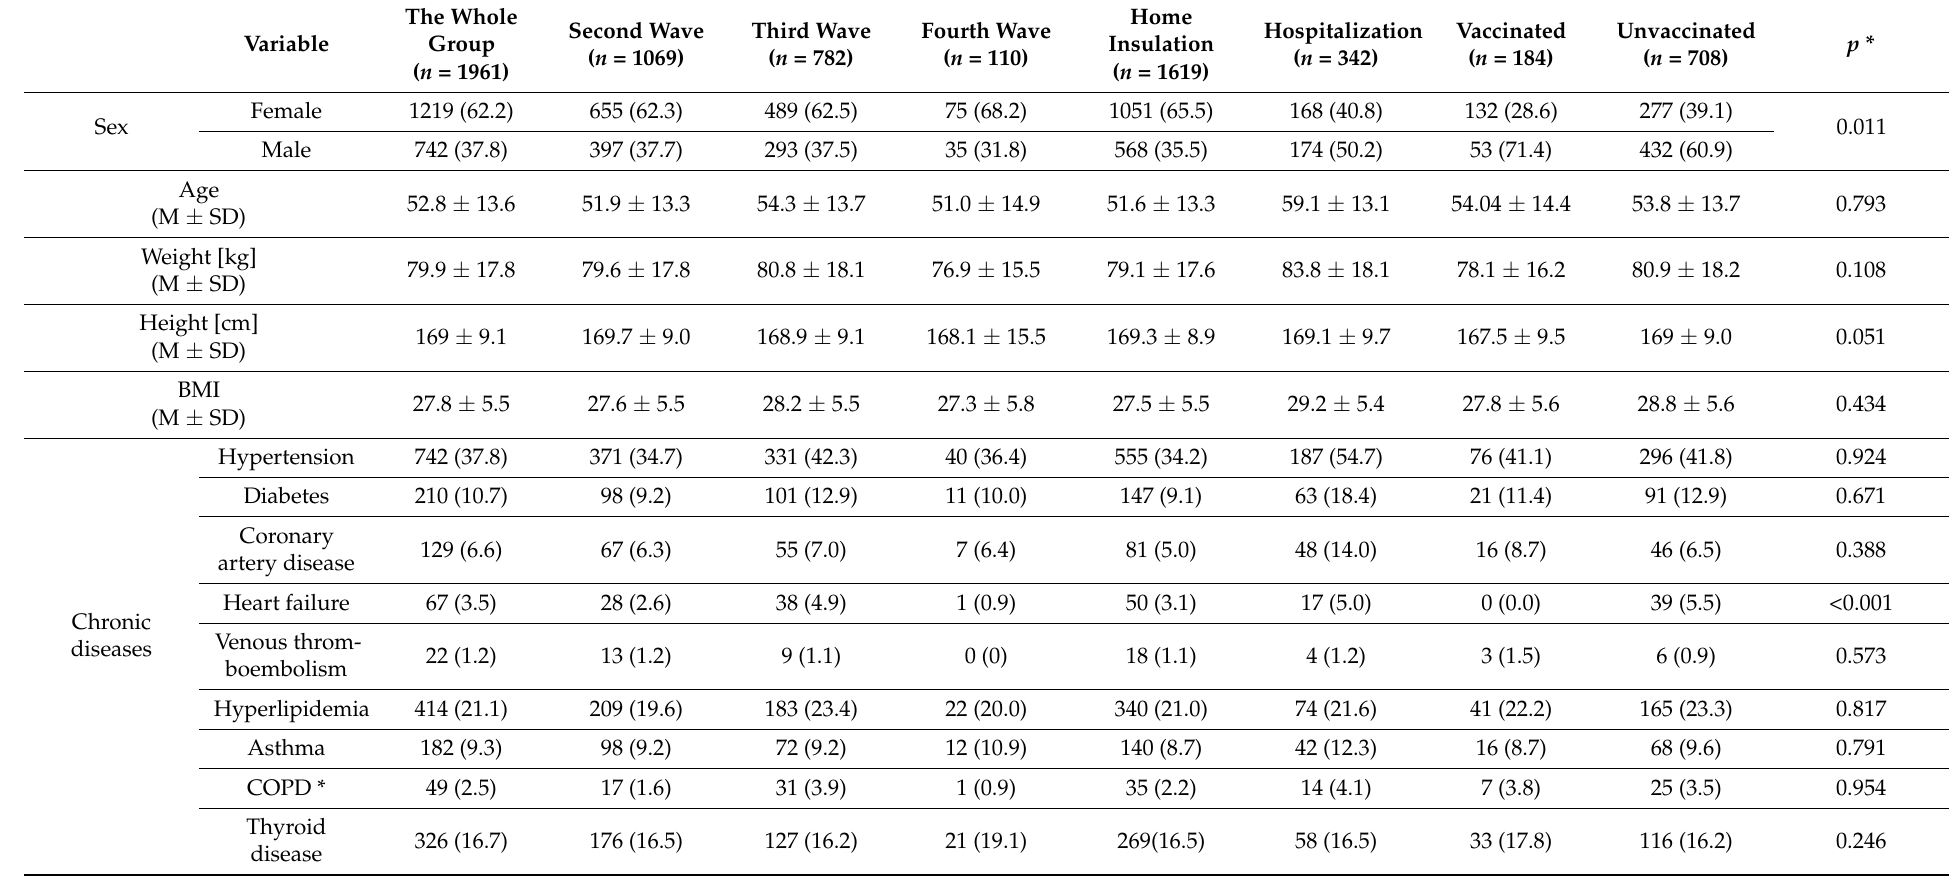
Table 1. Study group characteristics with reference to successive stages of the study, place of isolation and COVID-19 vaccination